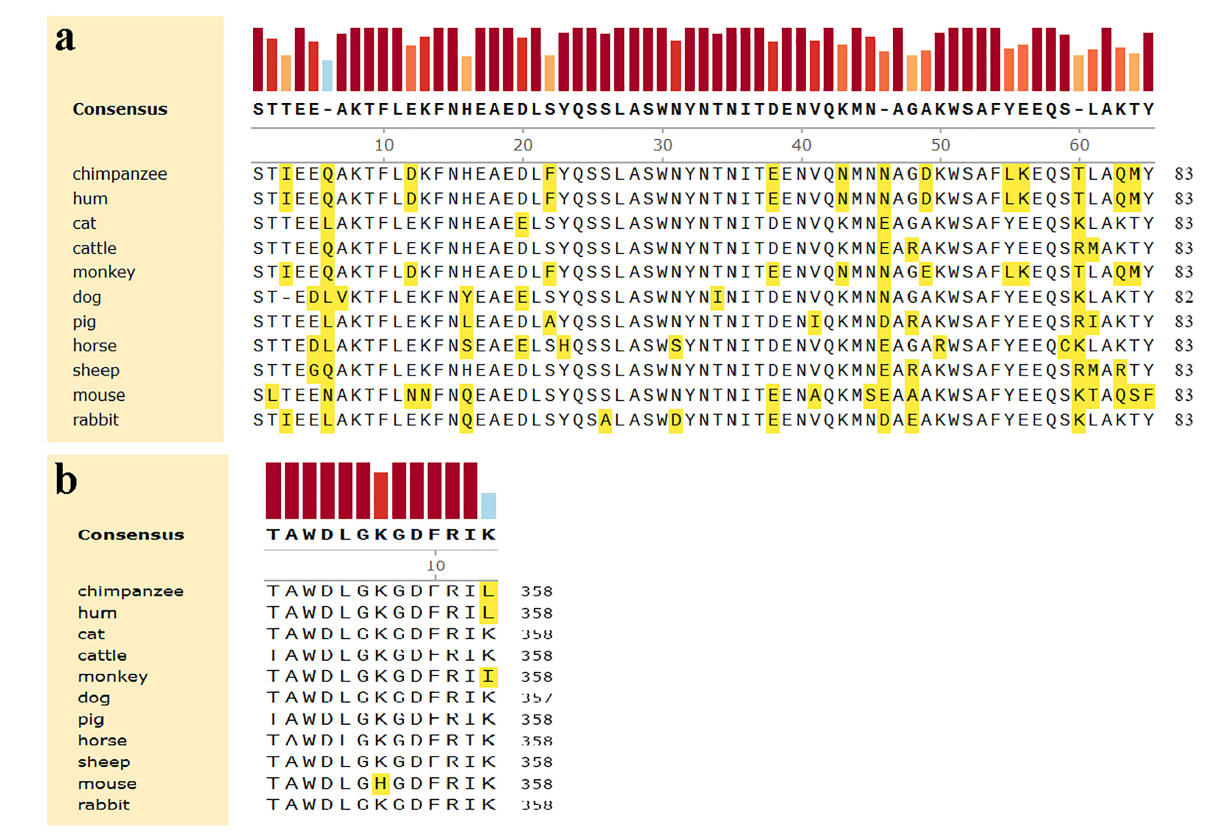
FIGURE 1 | Comparison of amino acids homology of ACE2 in the helical structure and the folding between human and other organisms. (a) The helical structure of 19–83 aa. (b) The folding structure of 347–358 aa. The different amino acids are shown in